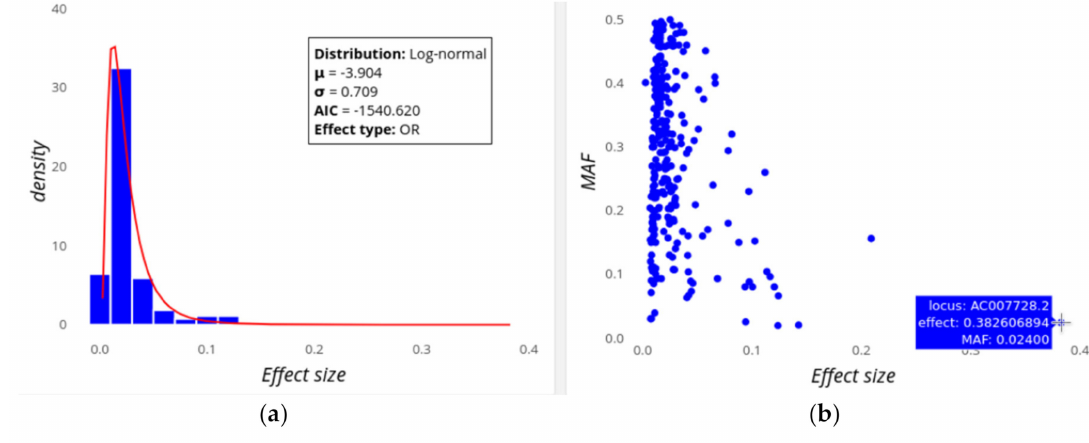
Figure 1. Screenshot of GWEHS (Genome-Wide E ff ect sizes and Heritability Screener) showing the distribution of loci e ff ect sizes for Digestive disease (i.e., Crohn’s disease and Inflammatory bowel disease), using the default parameters. ( a ) The observed distribution of locus e ff ect sizes (blue bars) and the fit to a log-normal distribution (red line), including a box with the distribution parameters, Akaike information criterion (AIC) value and the trait type. ( b ) Scatterplot illustrating the joint distribution of locus e ff ect sizes and the minor allele frequency or MAF, (blue points). The interactive panel allows the user to explore the individual loci (SNPs) on the plot. In the figure, a blue box indicates the locus (gene) name, e ff ect and MAF of the corresponding SNP with the highest e ff ect